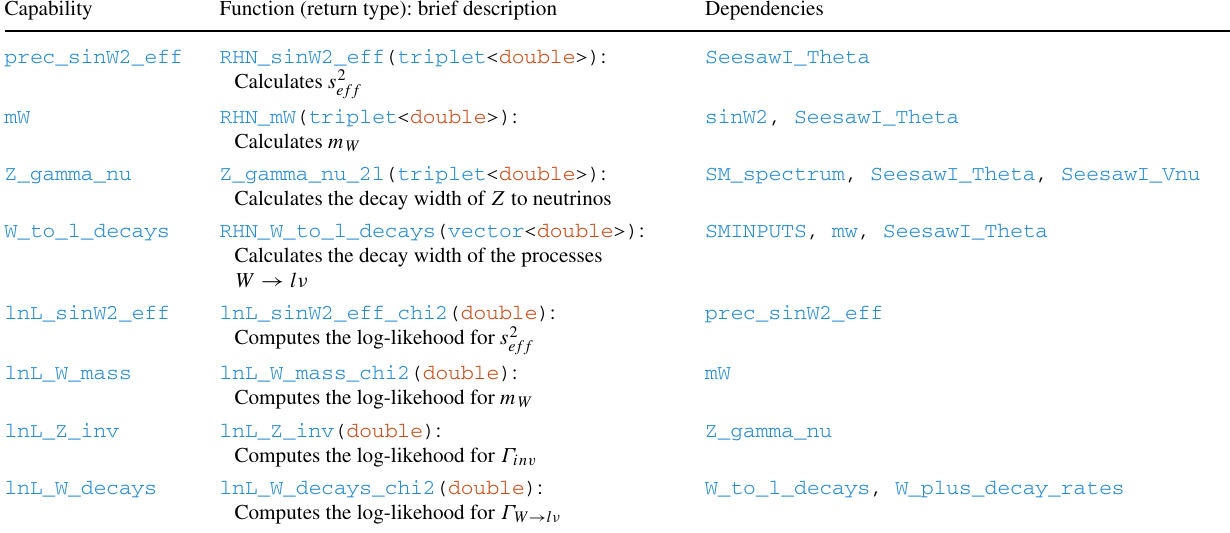
Table 10 Capabilities and module functions that calculate electroweak precision observables and their likelihoods